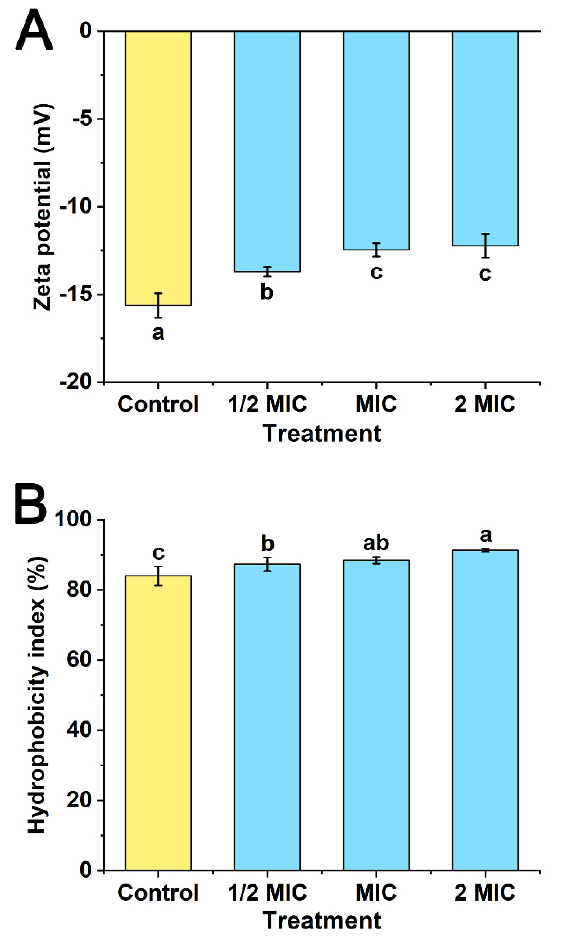
Figure 7. Effects of Polygonum orientale essential oil (concentration: 1/2MIC, MIC, and 2MIC) on zeta potential ( A ) and hydrophobicity ( B ). The group treated with DMSO (2%) served as the control. A significant difference was expressed ( p < 0.05).